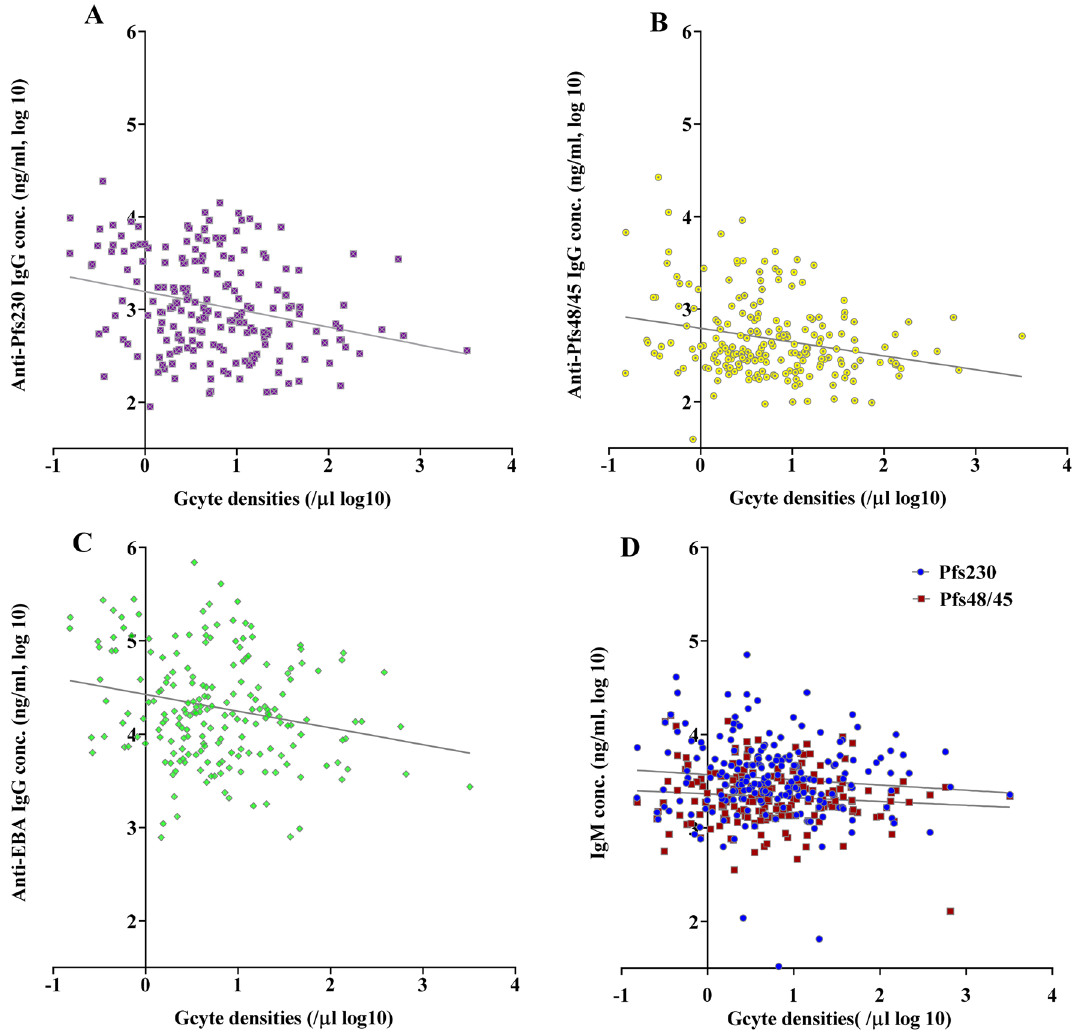
Figure 6. IgG antibody titers inversely correlate with gametocyte densities. Comparison of gametocyte densities estimated from Pfs25 RT-qPCR analysis and the corresponding IgG ( A – C ) titers against Pfs230proC, Pfs48/45.6C and EBA175RIII–V, and IgM ( D ) titers against Pfs230proC and Pfs48/45.6C. IgG, not IgM, responses were significantly inversely correlated with gametocyte densities. IgG Pearson r = − 0.2656*** (Pfs230), r = − 0.2505*** (Pfs48/45) r = − 0.2144** (anti-EBA175). IgM Pearson r = − 0.0929 ns (Pfs230) and r = − 0.1033 ns (Pfs48/454). ns p > 0.05, **p < 0.01, ***p ≤